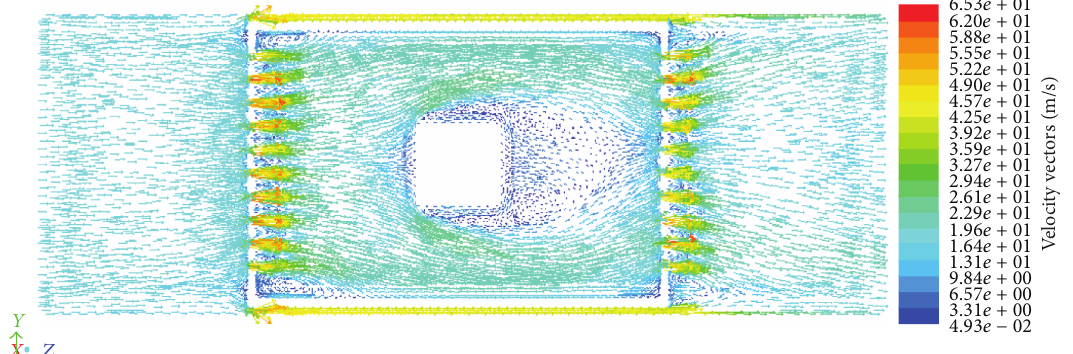
Figure 16: Velocity vector distribution of the long hole in the section 𝑍 = 0 .